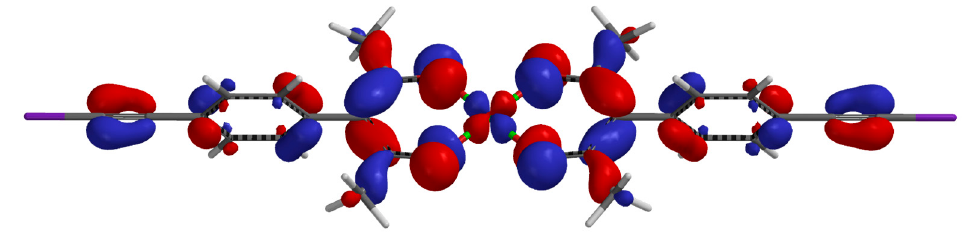
Figure 18. HOMO orbitals in Cu( L3 ) 2 (DFT B3LYP and basis set: 6-31G**, color codes: red and blue- two phases of HOMO orbitals).